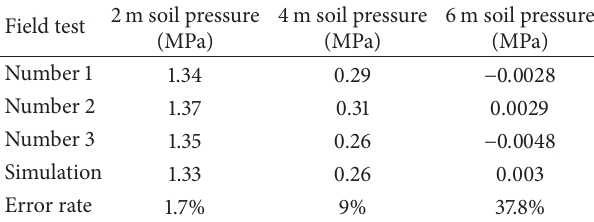
Figure 9: Simulated velocity curve. Table 5: Field monitored and model predicted